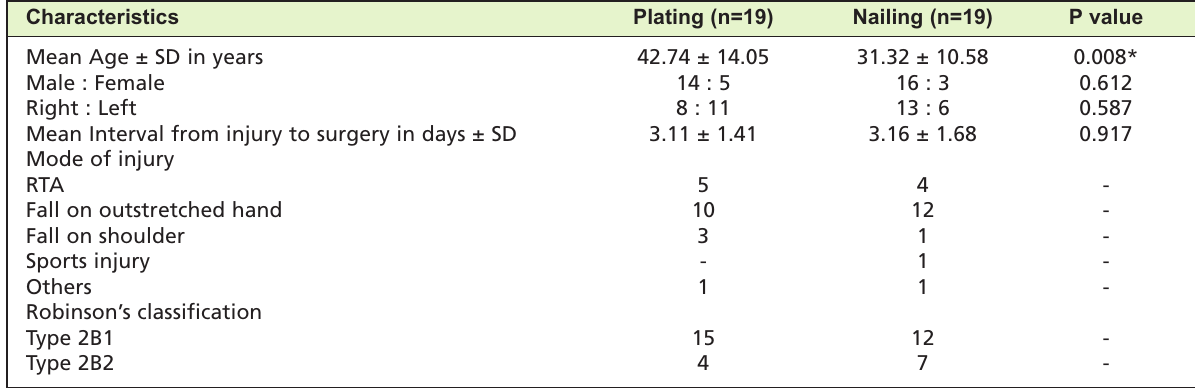
Baseline characteristics of both the groups Table I: